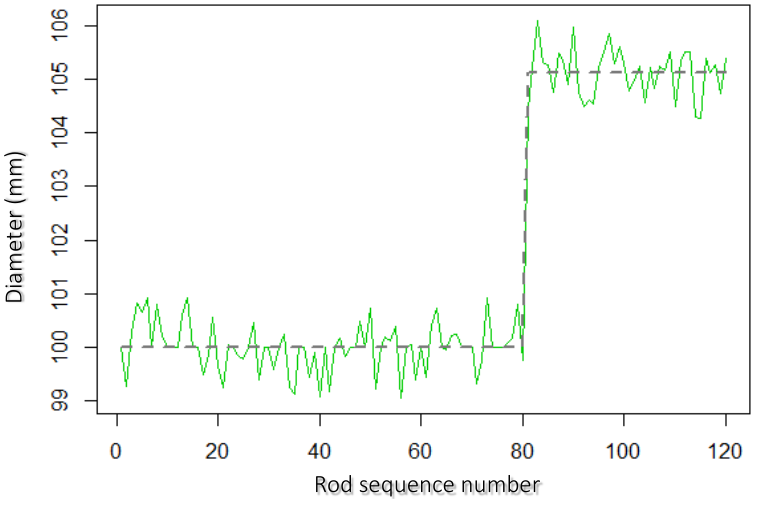
Figure 9. Fitted model with determinant variable and no regime change detected.